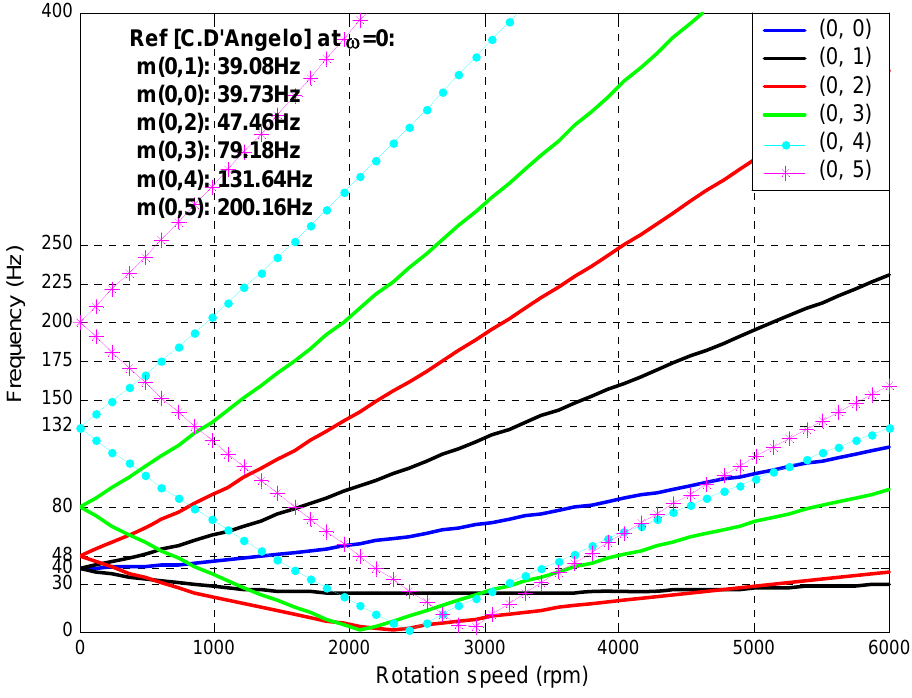
Figure 4. Mode frequency versus rotational speed of disk platter without air coupling.